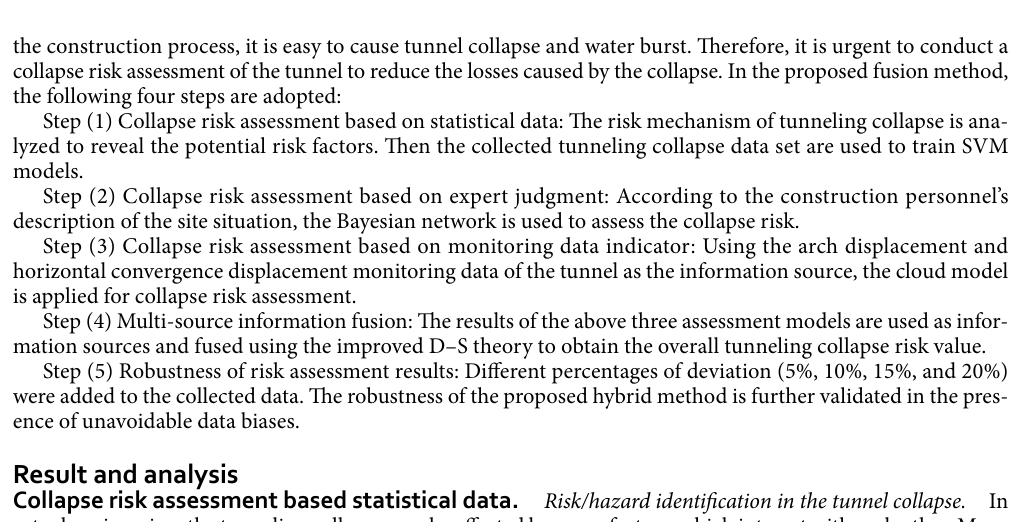
Figure 2. Fault structures along the Jinzhupa Tunnel (Figure no. 2 was drawn using AutoCAD software with version no. AutoCAD 2017 and link: https:// www. autod esk. com.